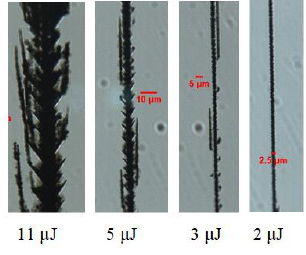
Fig. 2. Bessel beam laser-written graphitic wires in diamond